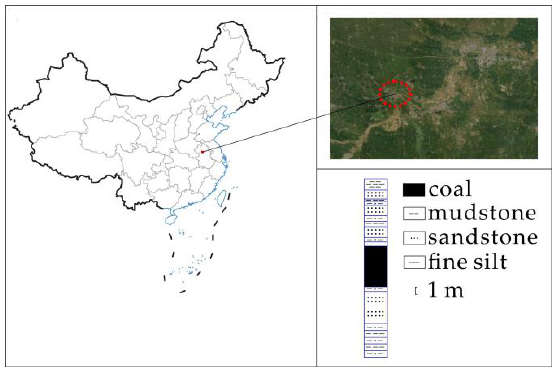
Figure 1. Study area location and lithology histogram. Table 1. The storage environment and genesis of the three kinds of unconventional natural gas.